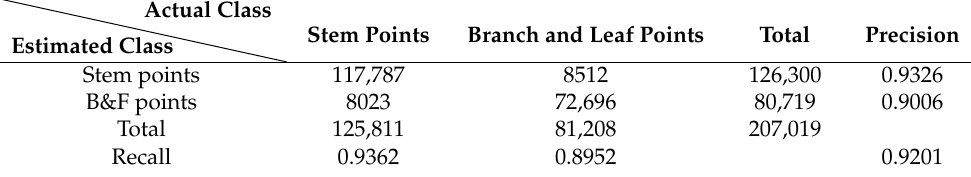
Table 5. Mixing matrix and precision value of test set